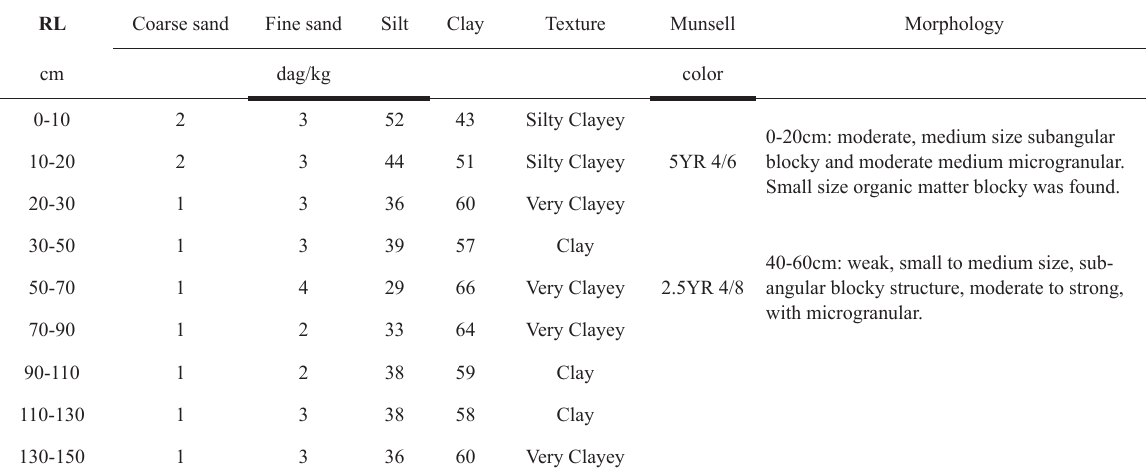
Physical and morphological traits of Red Latosol (RL) under Mesotrophic Cerradão (woodland) in Paraopeba National Reserve.